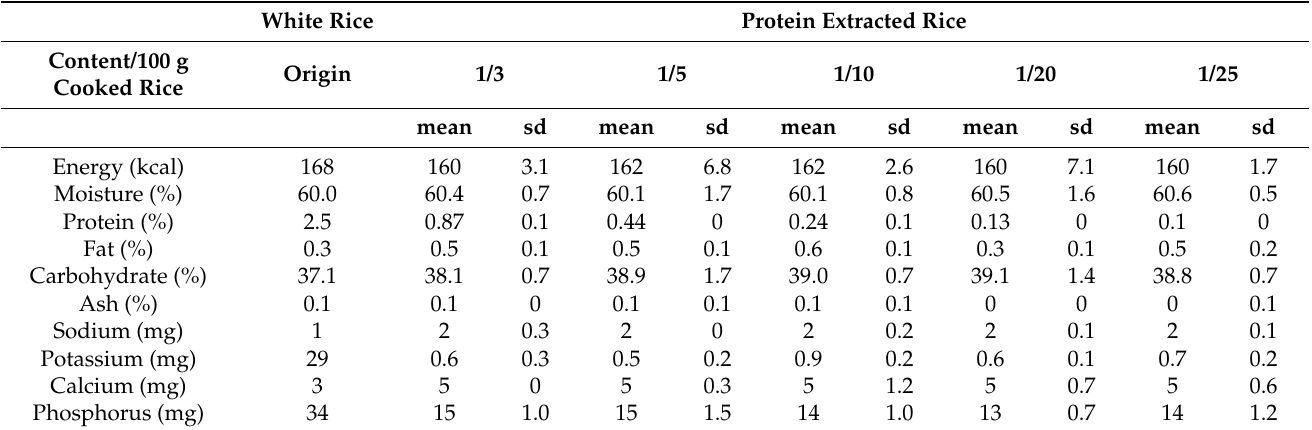
Table 1. Variety of PLC products from FORICA Co. Ltd. (Uonuma, Japan).